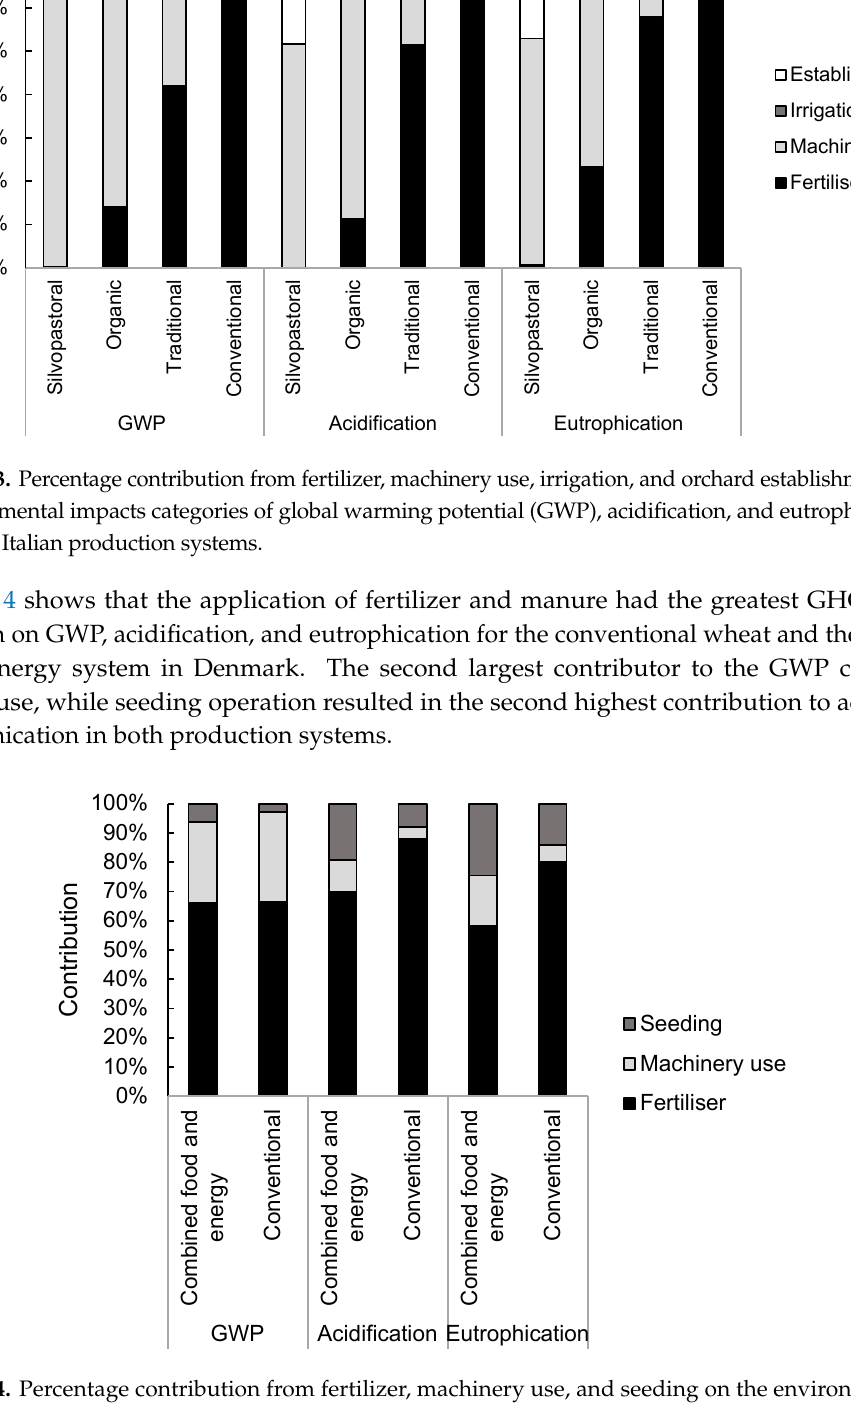
Figure 4. Percentage contribution from fertilizer, machinery use, and seeding on the environmental impact categories of global warming potential (GWP), acidification, and eutrophication for agroforestry and conventional production systems in Denmark.